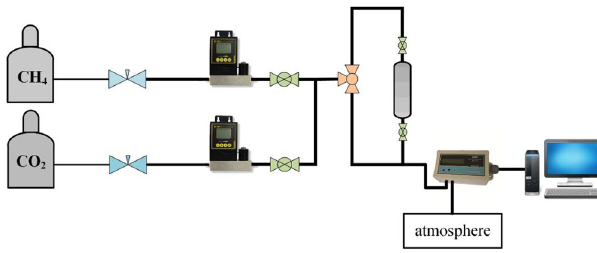
Figure 2. Schematic diagram of fixed-bed adsorption system.